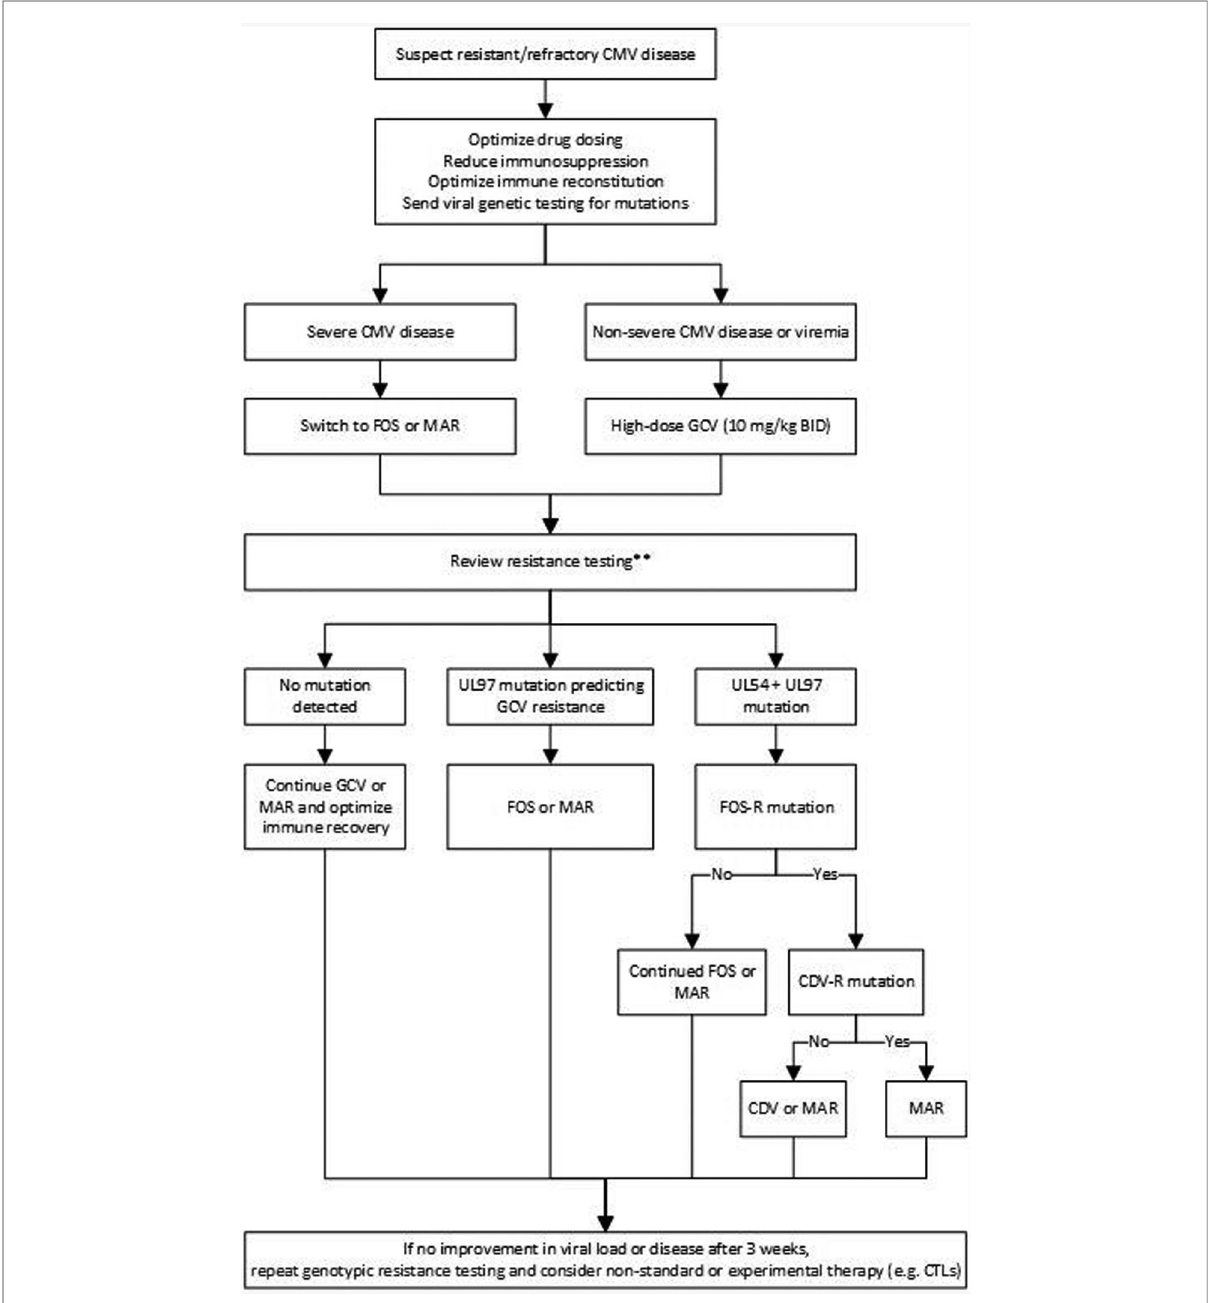
FIGURE 1 Proposed treatment algorithm for refractory/resistant CMV infection or disease (7, 9, 63, 64). GCV, ganciclovir; FOS, foscarnet; MAR, maribavir; CDV, cidofovir. **In the rare instance of UL54 mutation that predicts FOS-R alone (GCV-S) and without UL97 mutation, resume